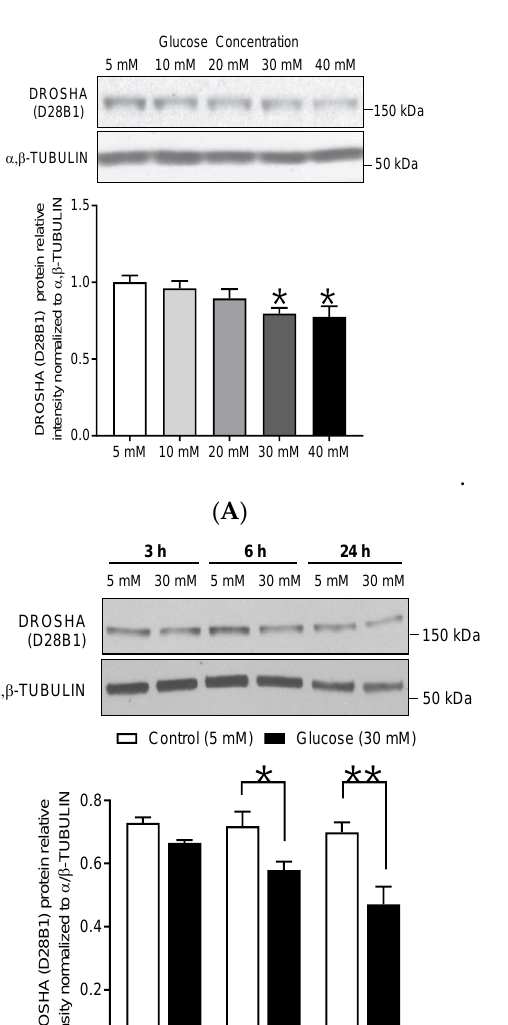
HDMECs treated with increasing concentrations of glucose for 24 h. α,β-TUBULIN was used as a loading control. Data are means ± SEM, n = 8. One-way ANOVA indicates a significant effect of glucose concentration ( p < 0.05); * indicates significant differences compared to 5 mM glucose condition ( p < 0.05, Bonferroni post hoc tests). ( C ) Immunoblot of DROSHA protein in HDMECs following 3, 6, and 24 h exposure to 5 and 30 mM glucose (data are means ± SEM, n = 3). ( D ) Immunoblots of DROSHA protein in HDMECs after 24 h treatment with 5 and 30 mM glucose, and 30 mM mannitol. Treatment with D-mannitol was used as an osmotic control. Data are means ± SEM, ** indicates significant difference